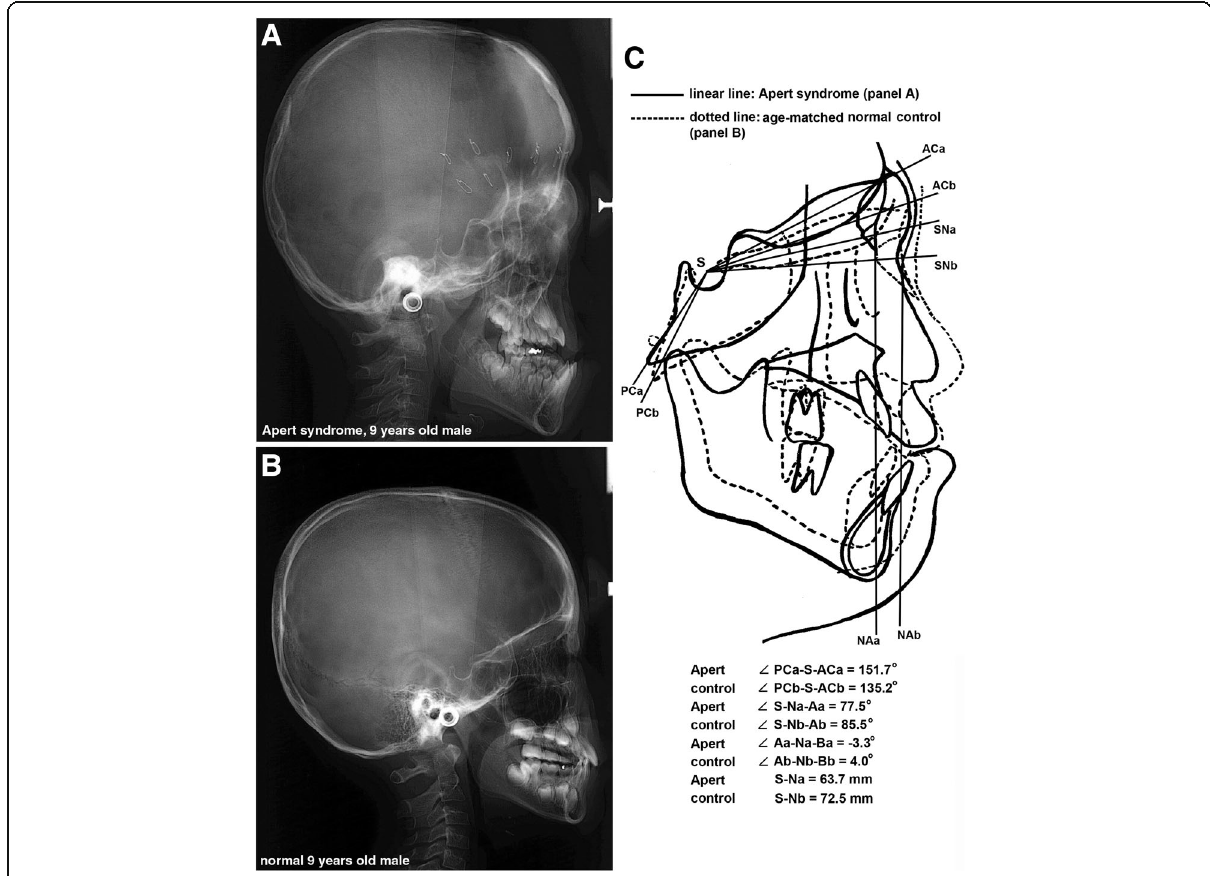
Fig. 4 Cephalogram: a An Apert syndrome patient, a 9-year-old male, noted with retained suture wires for distraction osteotomy performed at 6 months after birth. b A 9-year-old normal male. c overlapping cephalogram panels a and b by adjusting to the SN line. The Apert syndrome patient showed an increased posterior-anterior cranial base angle (angle PC-S-AC), a retruded maxilla, and a counter-clockwise growth of the mandible compared to the